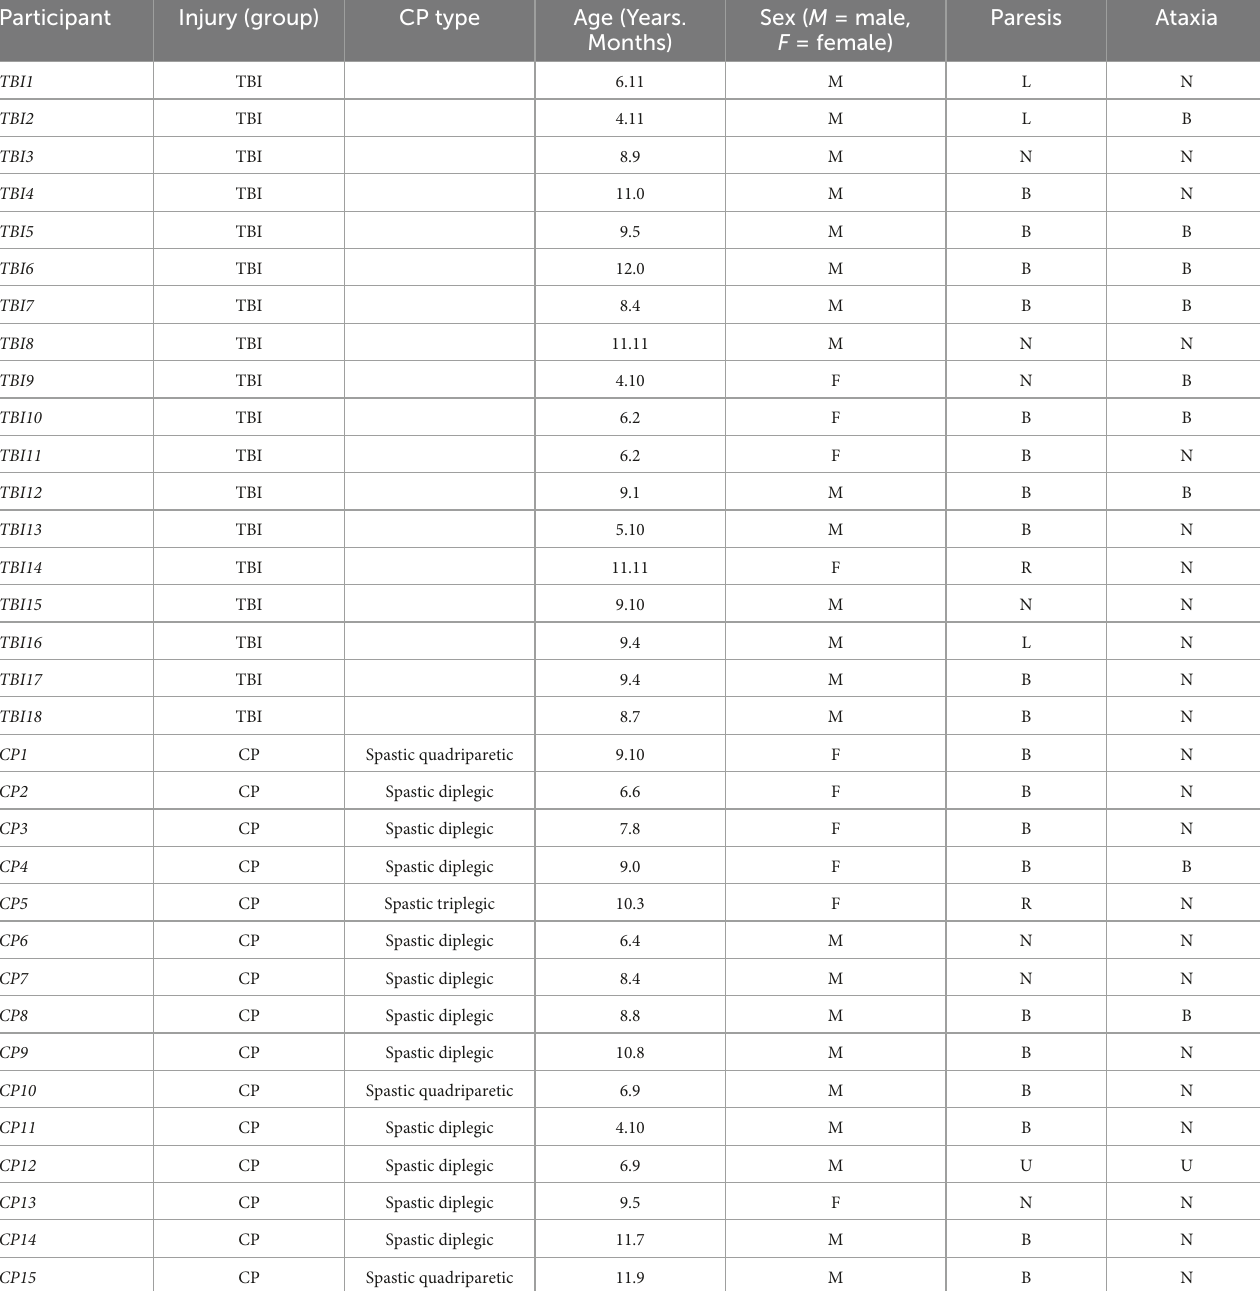
TABLE 1 Demographics data about the